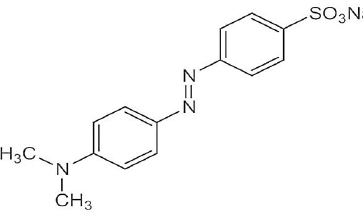
Figure 1. Methyl orange dye chemical structure.